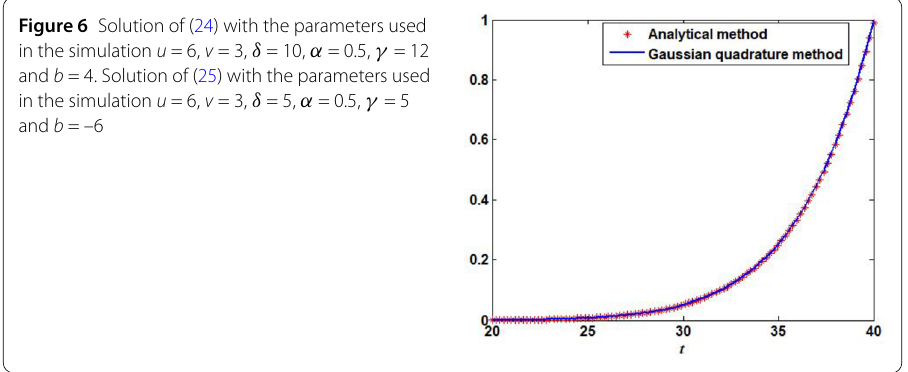
Figure 6 Solution of (24) with the parameters used in the simulation u = 6, v = 3, δ = 10, α = 0.5, γ = 12 and b = 4. Solution of (25) with the parameters used in the simulation u = 6, v = 3, δ = 5, α = 0.5, γ =